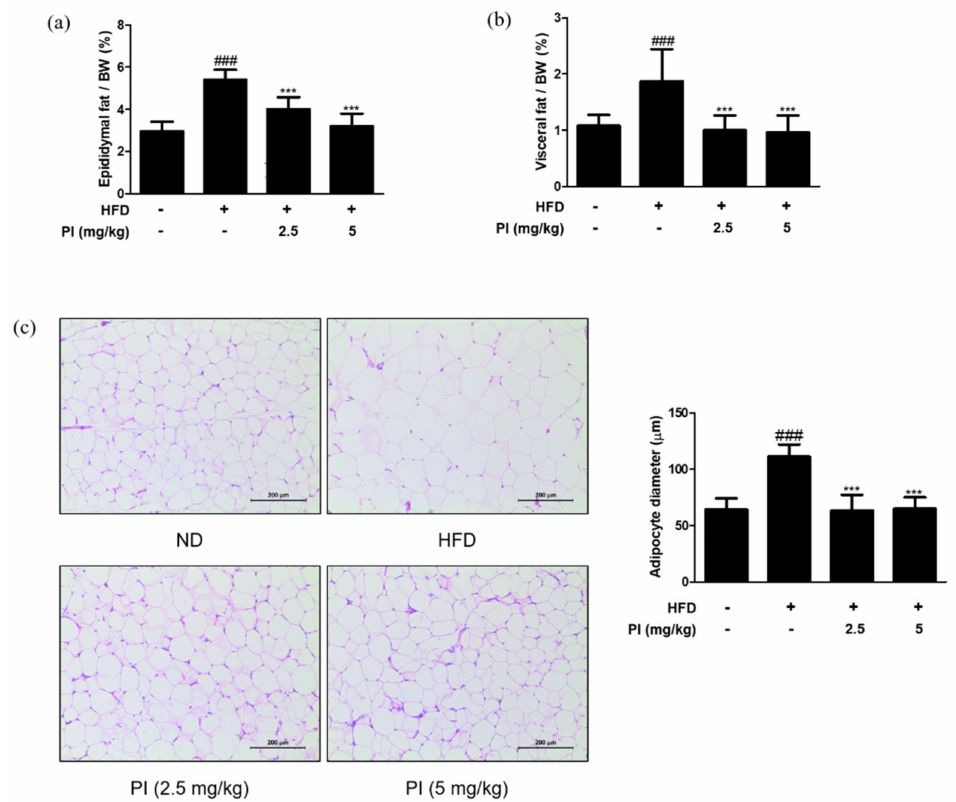
Figure 4. Effects of papain on adipose tissue weight and adipocyte hypertrophy in HFD–induced obese mice. ( a ) Relative epididymal adipose tissue weight ratio and ( b ) relative visceral adipose tissue weight ratio measured after 9 weeks of diet treatments in mice. ( c ) Representative histological images of the epididymal adipose tissue were assessed using H&E staining (original magnification; 200 × ). The epididymal white adipose tissue from representative mice in each group was fixed, embedded in paraffin, and stained with H&E. Adipocyte diameter was quantified under microscope quantified from representative sections. The values are given as the mean ± SD ( n = 6). The values are given as the mean ± SD ( n = 6). ### p < 0.001 vs. ND group; *** p < 0.001 vs. HFD